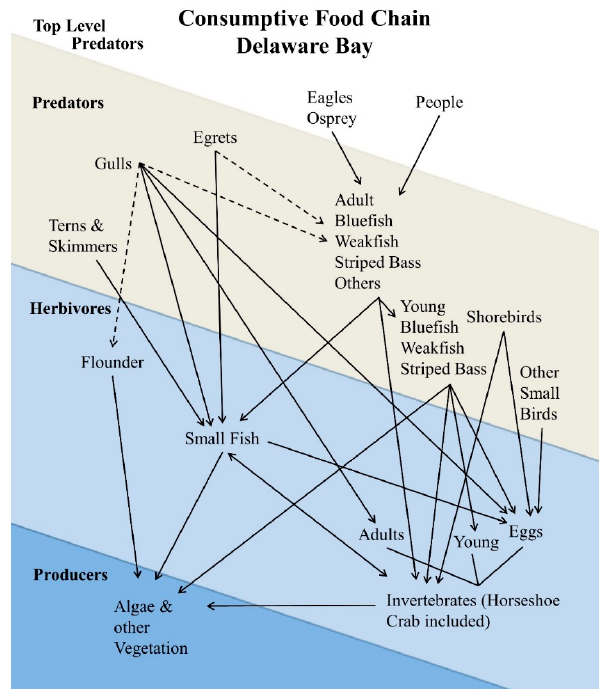
Figure 2. Schematic diagram of the consumption food web of Delaware Bay.